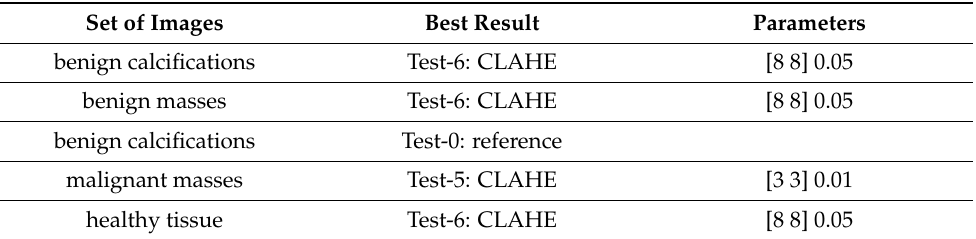
Table 7. Test that offers the best precision for each set of images, indicating the algorithm and its